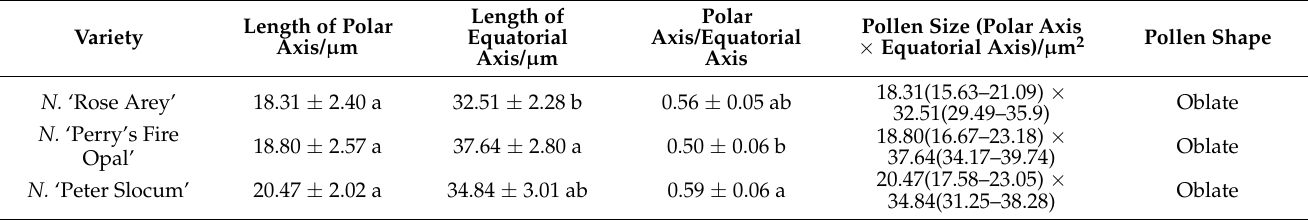
Table 2. Pollen morphological characteristic values of the three hardy water lily varieties.